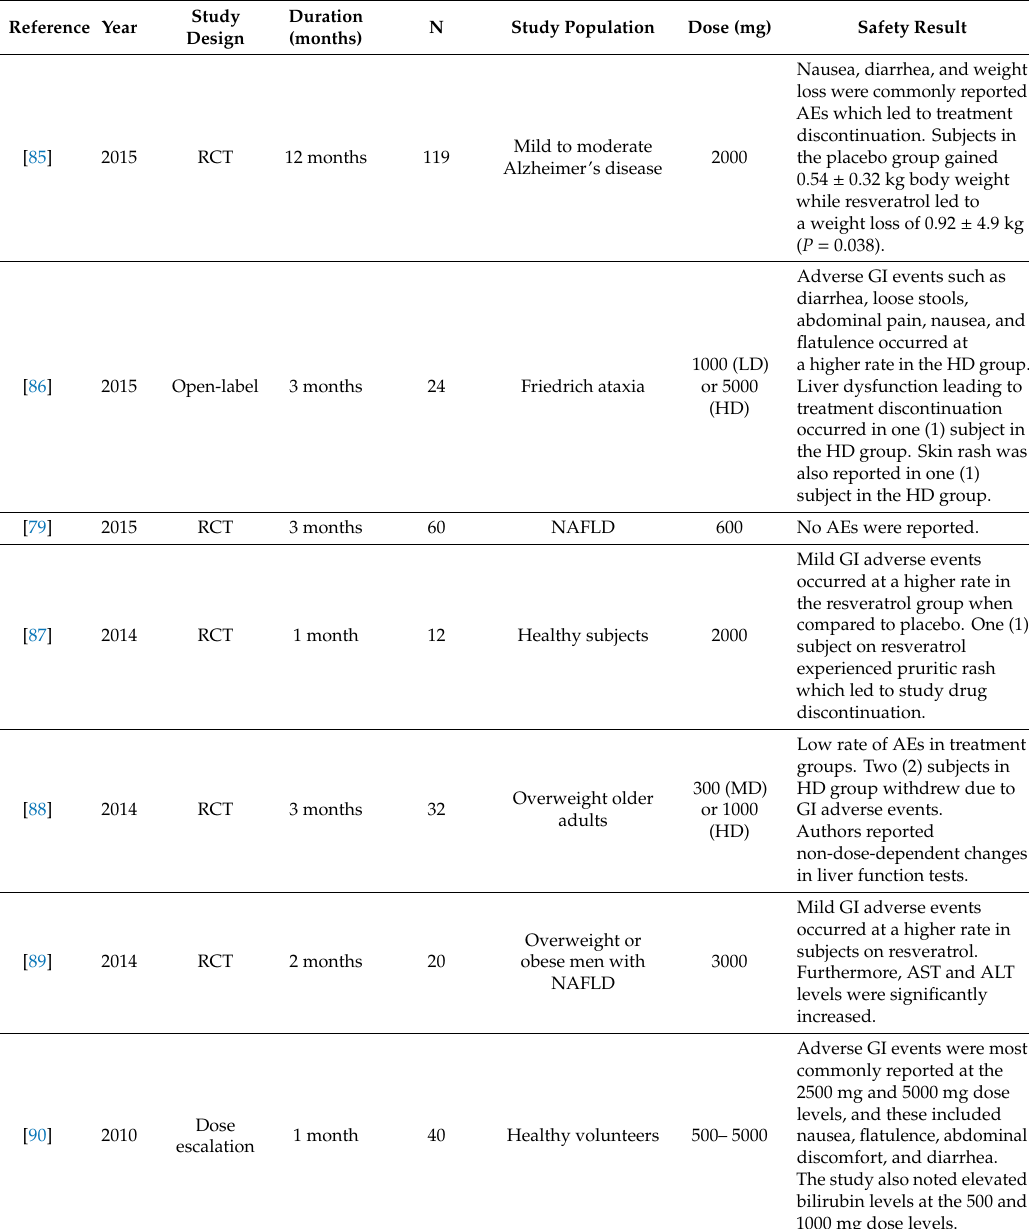
Table 3. Summary of Safety Profile of